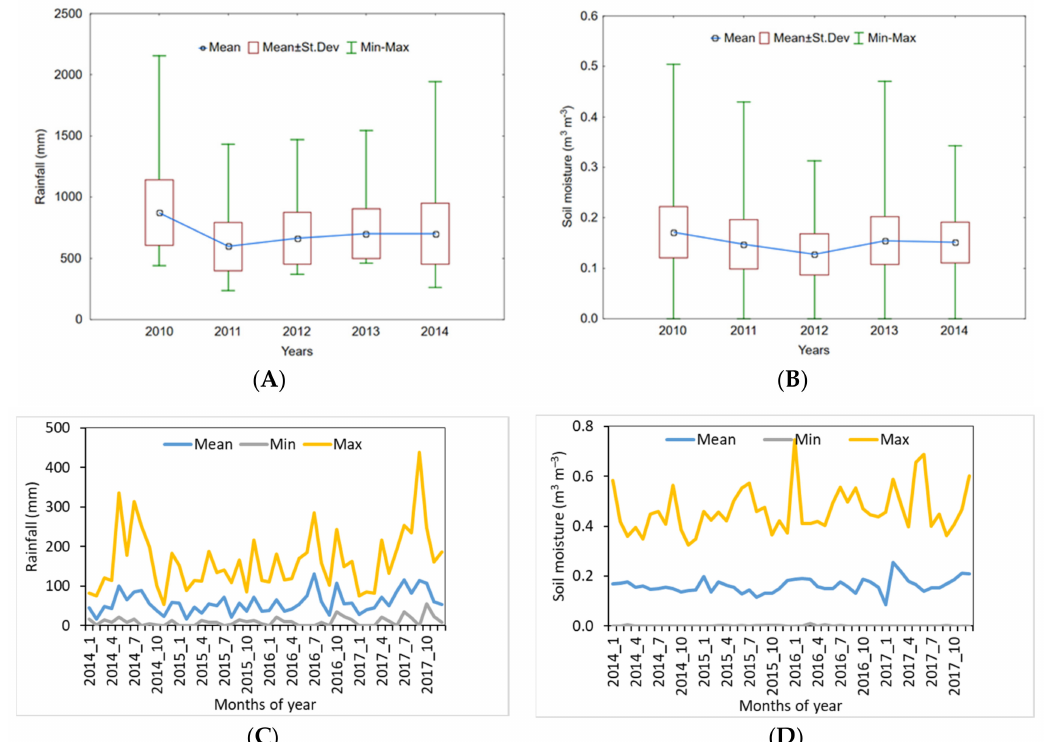
Figure 2. Mean, minimal (Min), and maximal (Max) values for annual rainfall ( A ) and soil moisture data ( B ) with standard deviations in Poland and neighbouring countries for the study period 2010–2014 and for monthly rainfall ( C ) and soil moisture data ( D ) in Poland for the study period